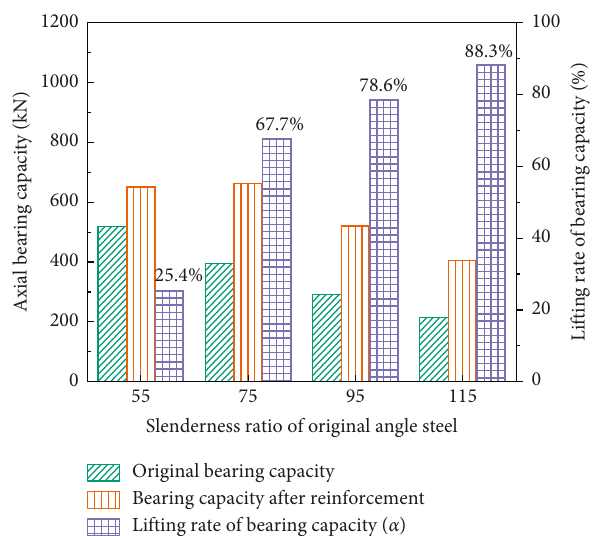
Figure 12: Effect of improving the bearing capacity with different slenderness ratios.